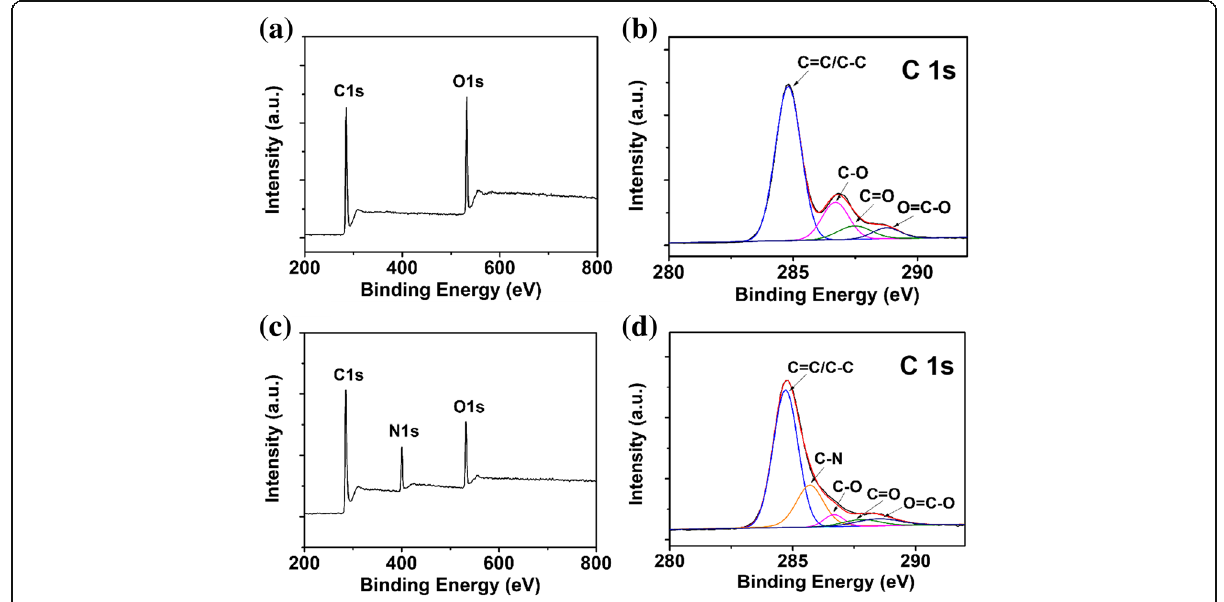
Fig. 3 XPS spectra of Cls of HGO before ( a ) and after the reduction ( b ). XPS spectra of HGO ( c ) and rHGO ( d )